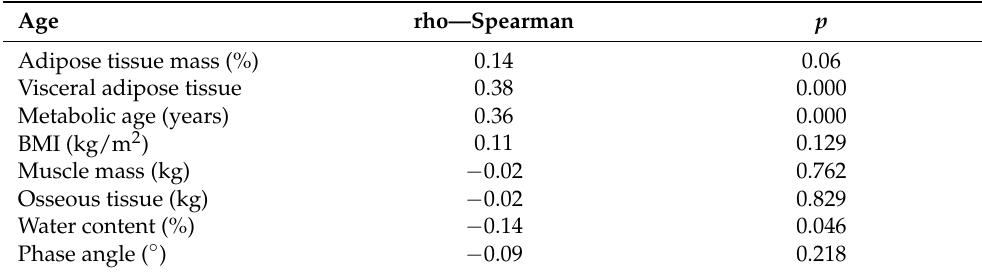
Table 5. The influence of age on the body composition analysis in the studied women.